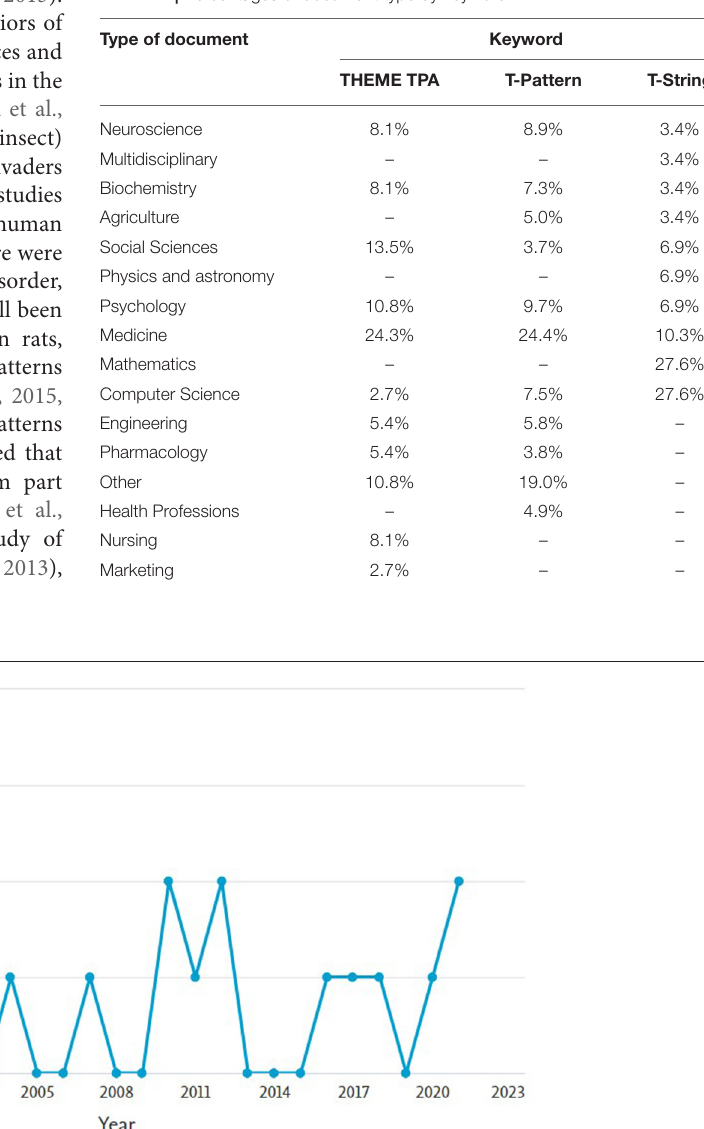
TABLE 1 | Percentages of document type by keyword.